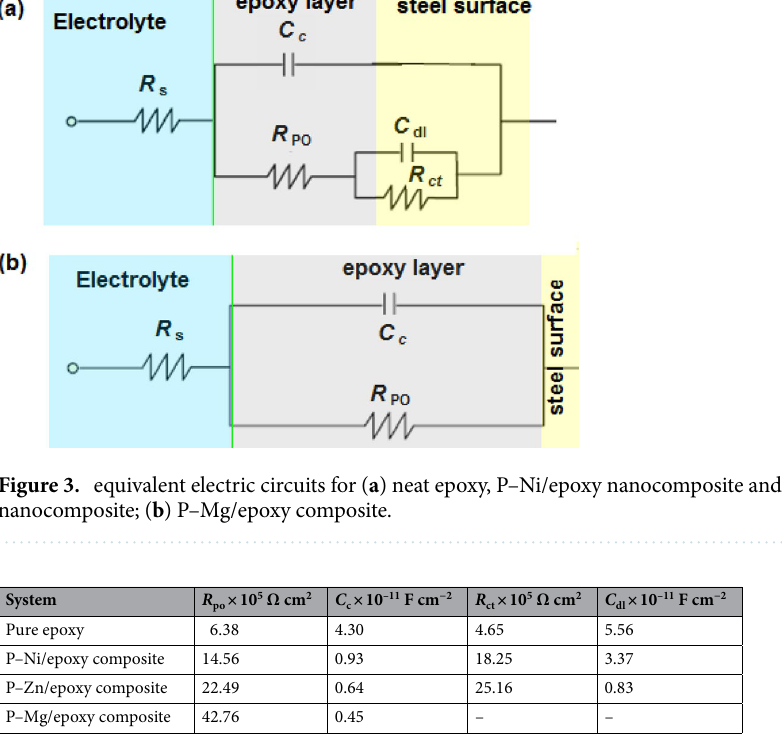
Table 1. EIS parameters of coated carbon steel with neat epoxy and new nanocomposite coatings in 3.5% NaCl solution at 303 K.